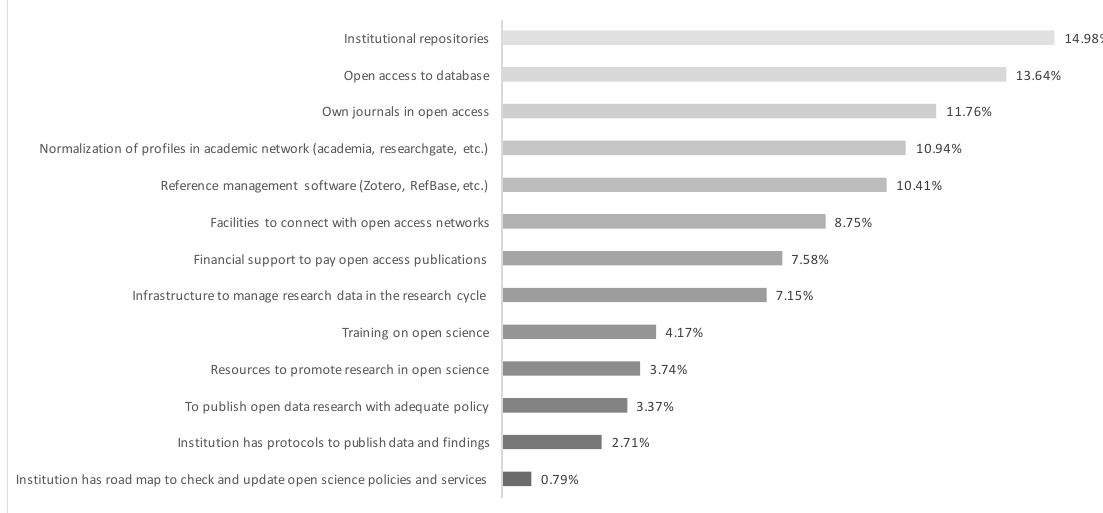
Figure A5. Open science tools used by universities and research centres in Colombia.